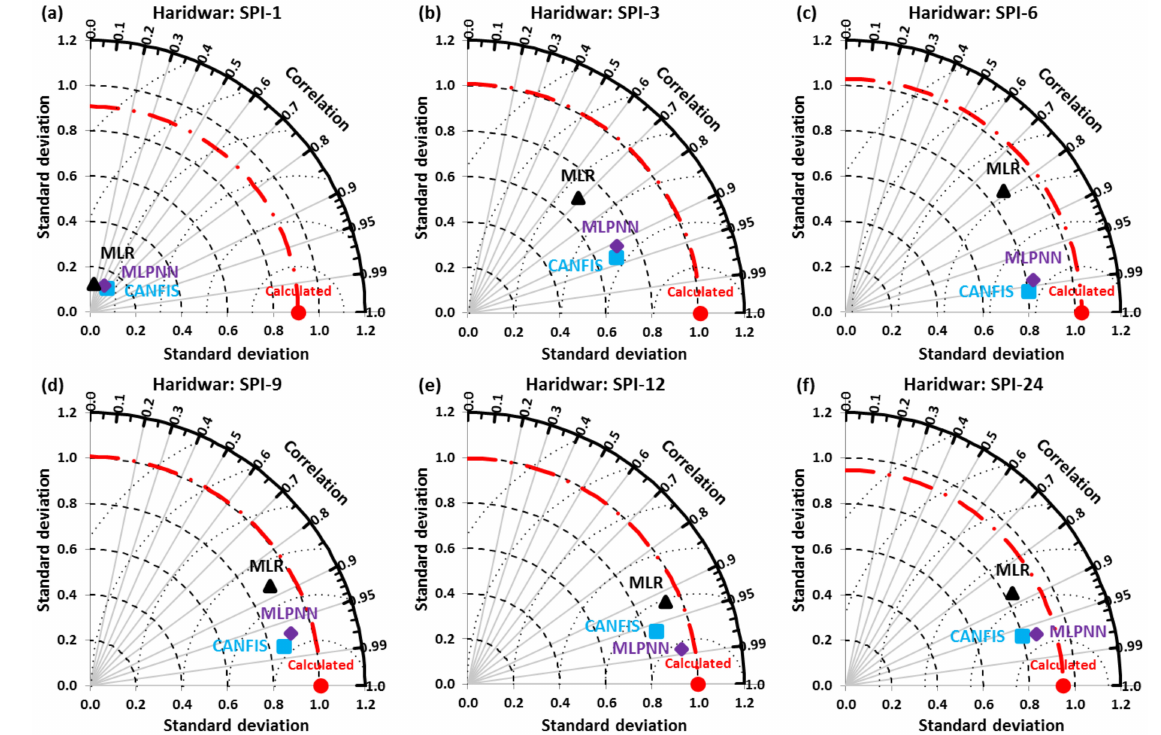
Figure 13. ( a – f ) Taylor diagram of predicted and calculated multi-scalar SPI at Haridwar station.